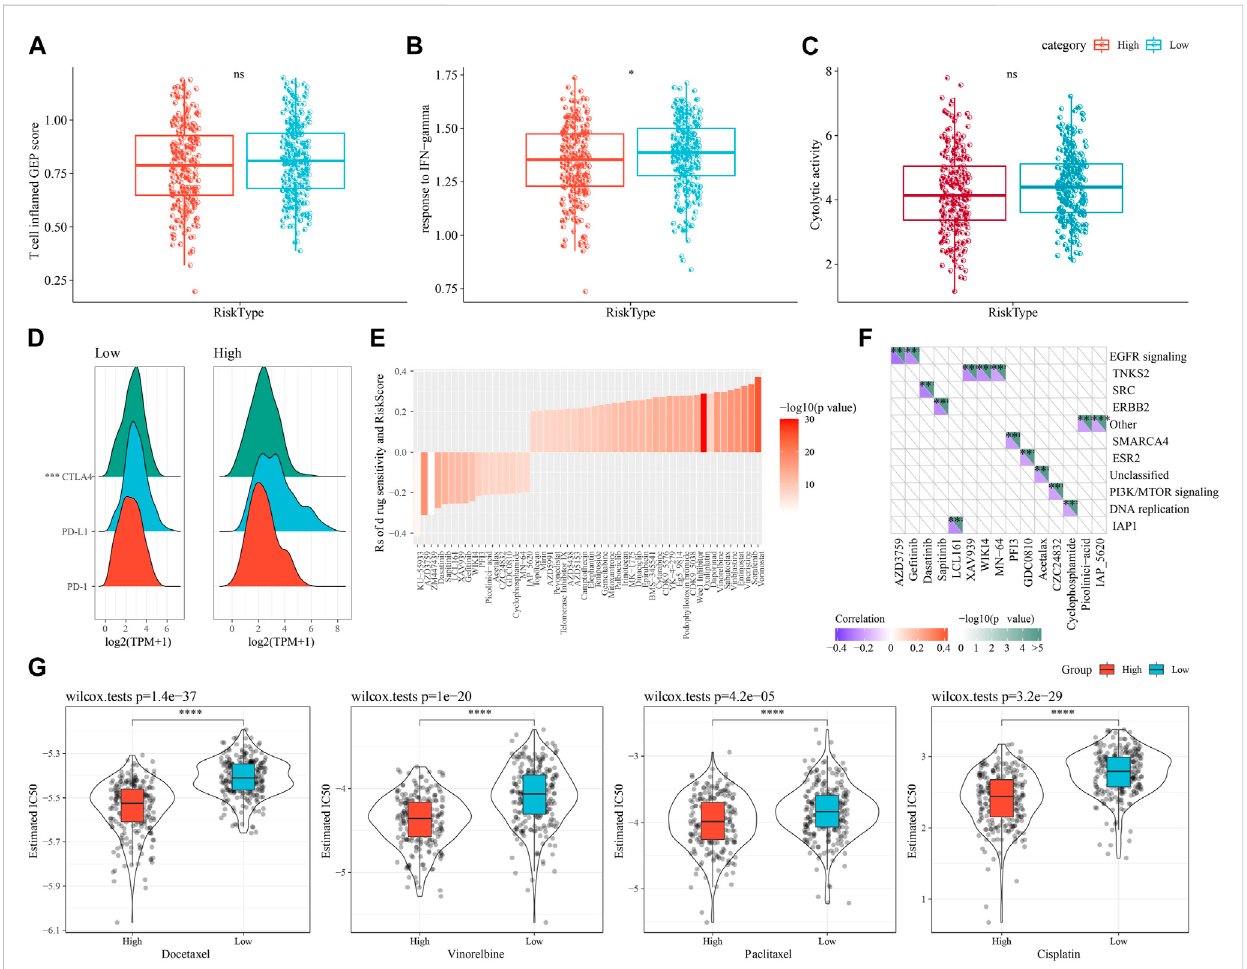
FIGURE 10 Differences in immunotherapy/chemotherapy between RiskScore subgroups. (A) Difference in “ T cell in fl amed GEP score ” between molecular subtypes. (B) Difference in “ response to IFN- γ " between molecular subtypes. (C) Differences in “ Cytolytic activity ” between molecular subtypes. (D) Differences in expression of immune checkpoint genes between molecular subtypes. (E) 15 pairs drugs were signi fi cantly associated to RiskScore. (F) 15 pairs drugs mainly target EGFR signaling and TNKS2 pathways. (G) IC50 box plots of docetaxel, vincristine, paclitaxel and cisplatin in TCGA-LUAD